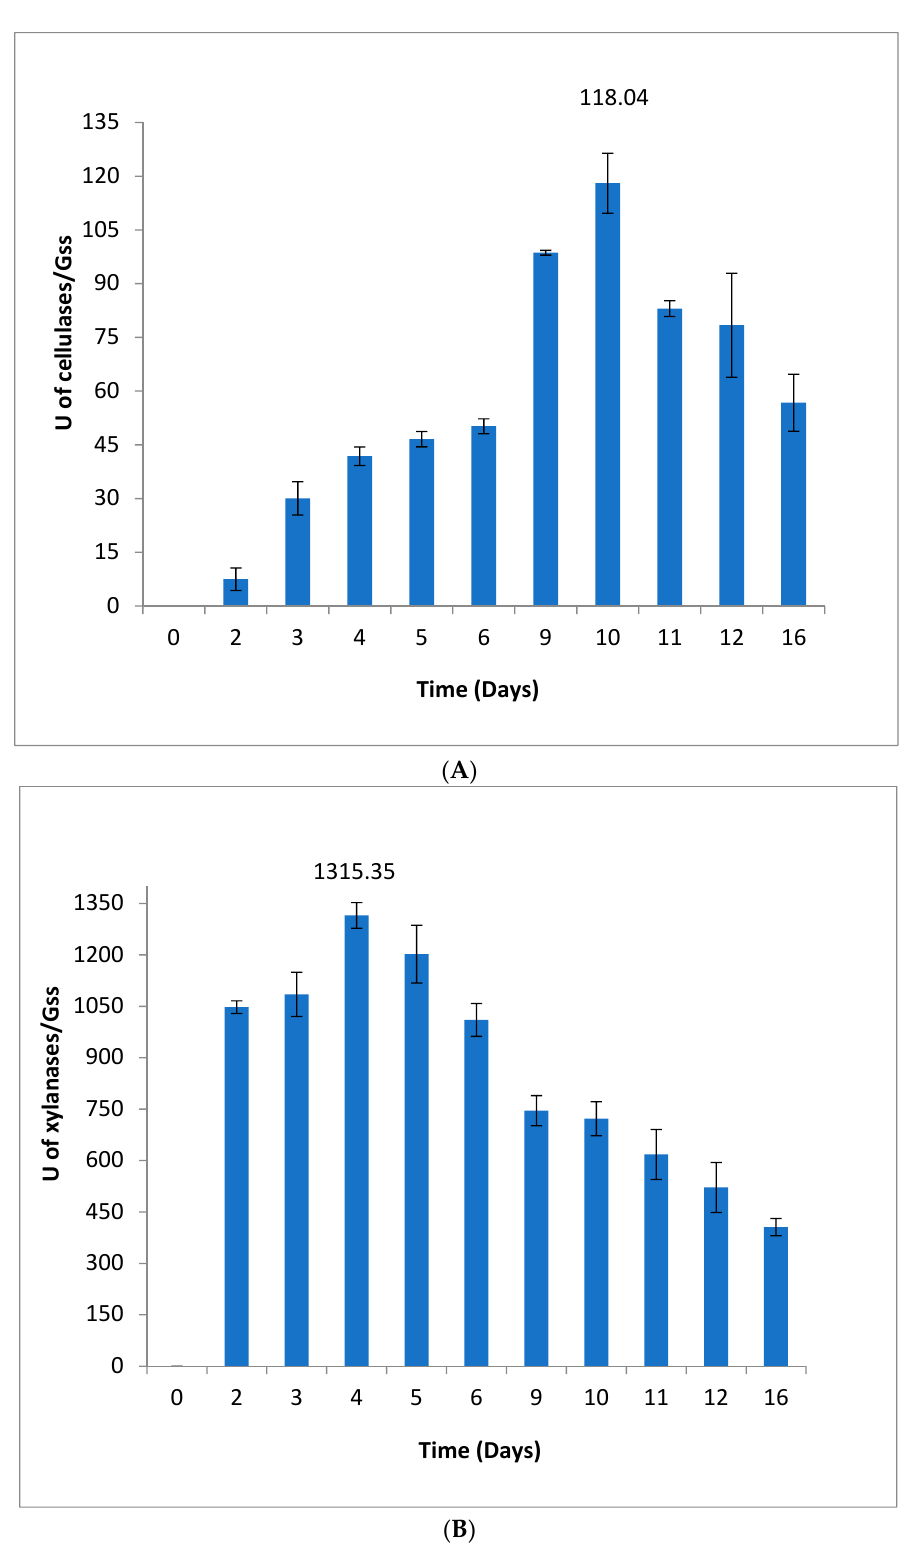
Figure 4. Time course of ( A ) cellulase and ( B ) xylanase activities produced by Aspergillus niger LPB-334 in SSF on BSG. The error bars represent standard deviations. The averages of results of three independent experiments, each one performed with three biological replicates, are reported.